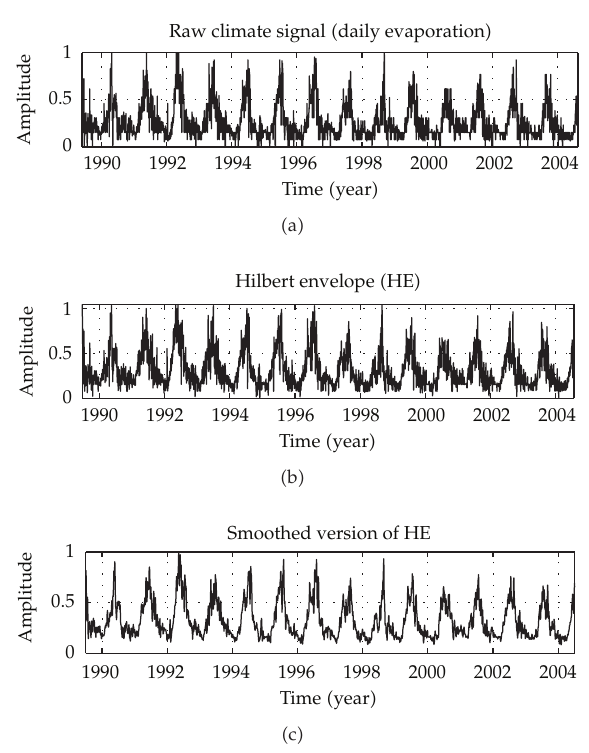
Figure 7: Preprocessing of the raw climate signal. The original climate signal (cid:2) a (cid:3) , the Hilbert envelope (cid:2) b (cid:3) , and the smoothed version of the Hilbert envelope (cid:2) c (cid:3)